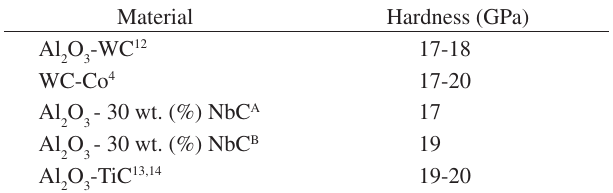
Figure 4. X ray diffraction pattern of the composite material with 40 wt. (%) Table 1. Comparison of the hardness values among the material obtained in this work with the traditional cutting tool material.